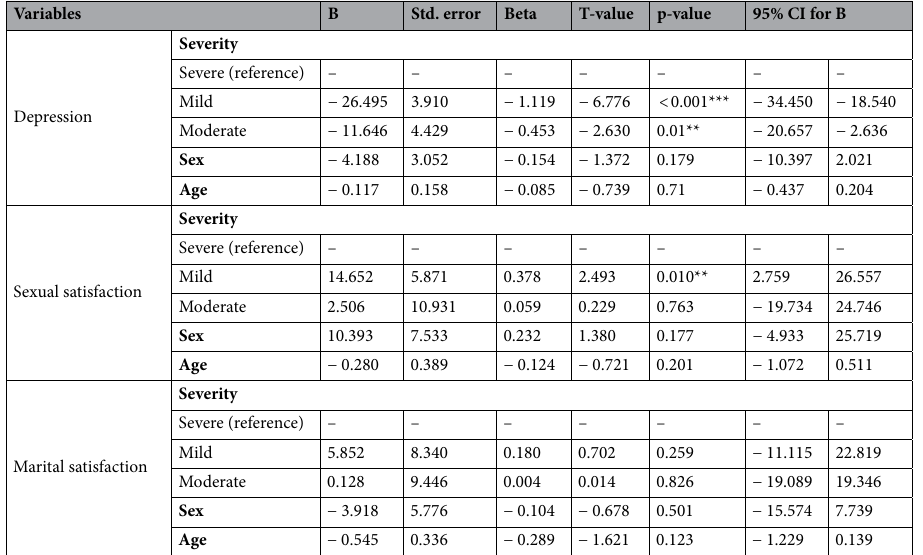
Table 2. Multivariable regression predicting sexual and marital satisfaction and depression. **p < 0.05, Sexual satisfaction in mild trauma vs. severe trauma. ***p < 0.001, Depression in mild trauma vs. sever